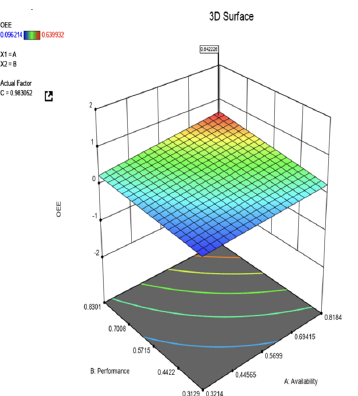
Fig. 12. 3D Response surface plot – Quality vs Performance Fig. 11. 3D Response surface plot – Performance vs Avail- ability